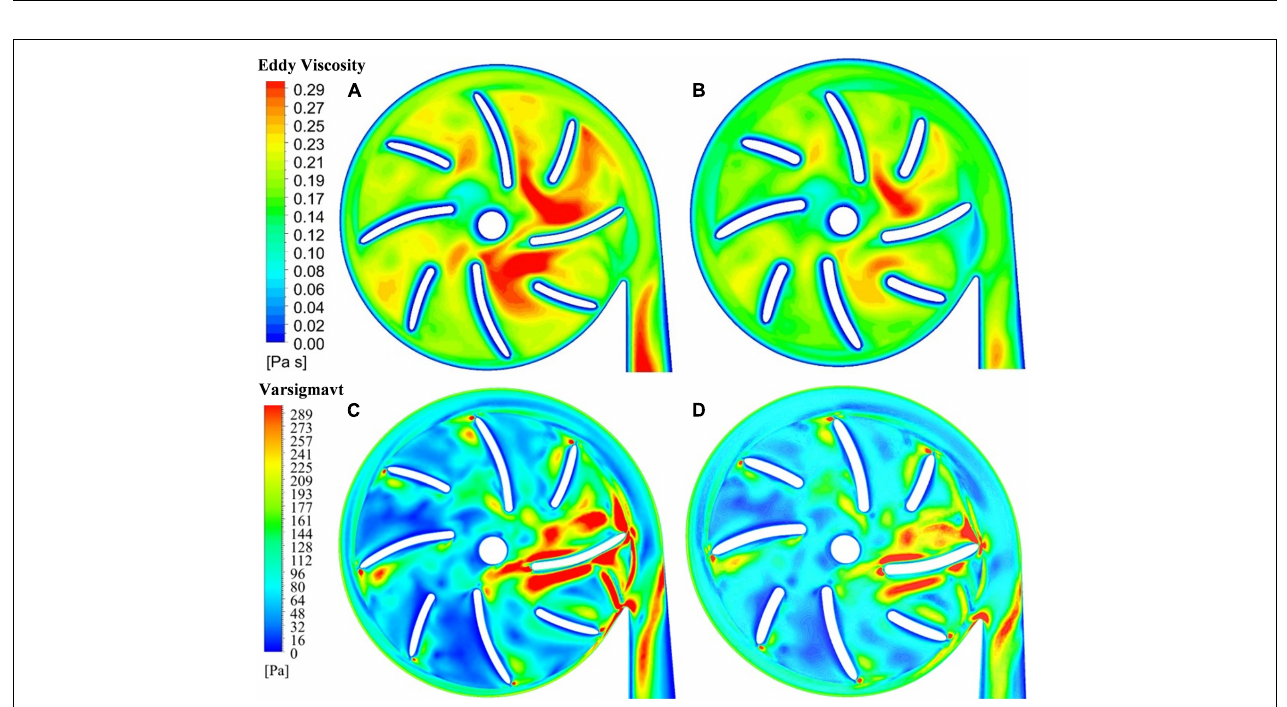
FIGURE 6 | Contour of turbulent viscosity: (A) model 2 (blade thickness of 1.5 mm); (B) model 3 (blade thickness of 2 mm); contour of effective stress: (C) model 2 (blade thickness of 1.5 mm); (D) model 3 (blade thickness of 2 mm).